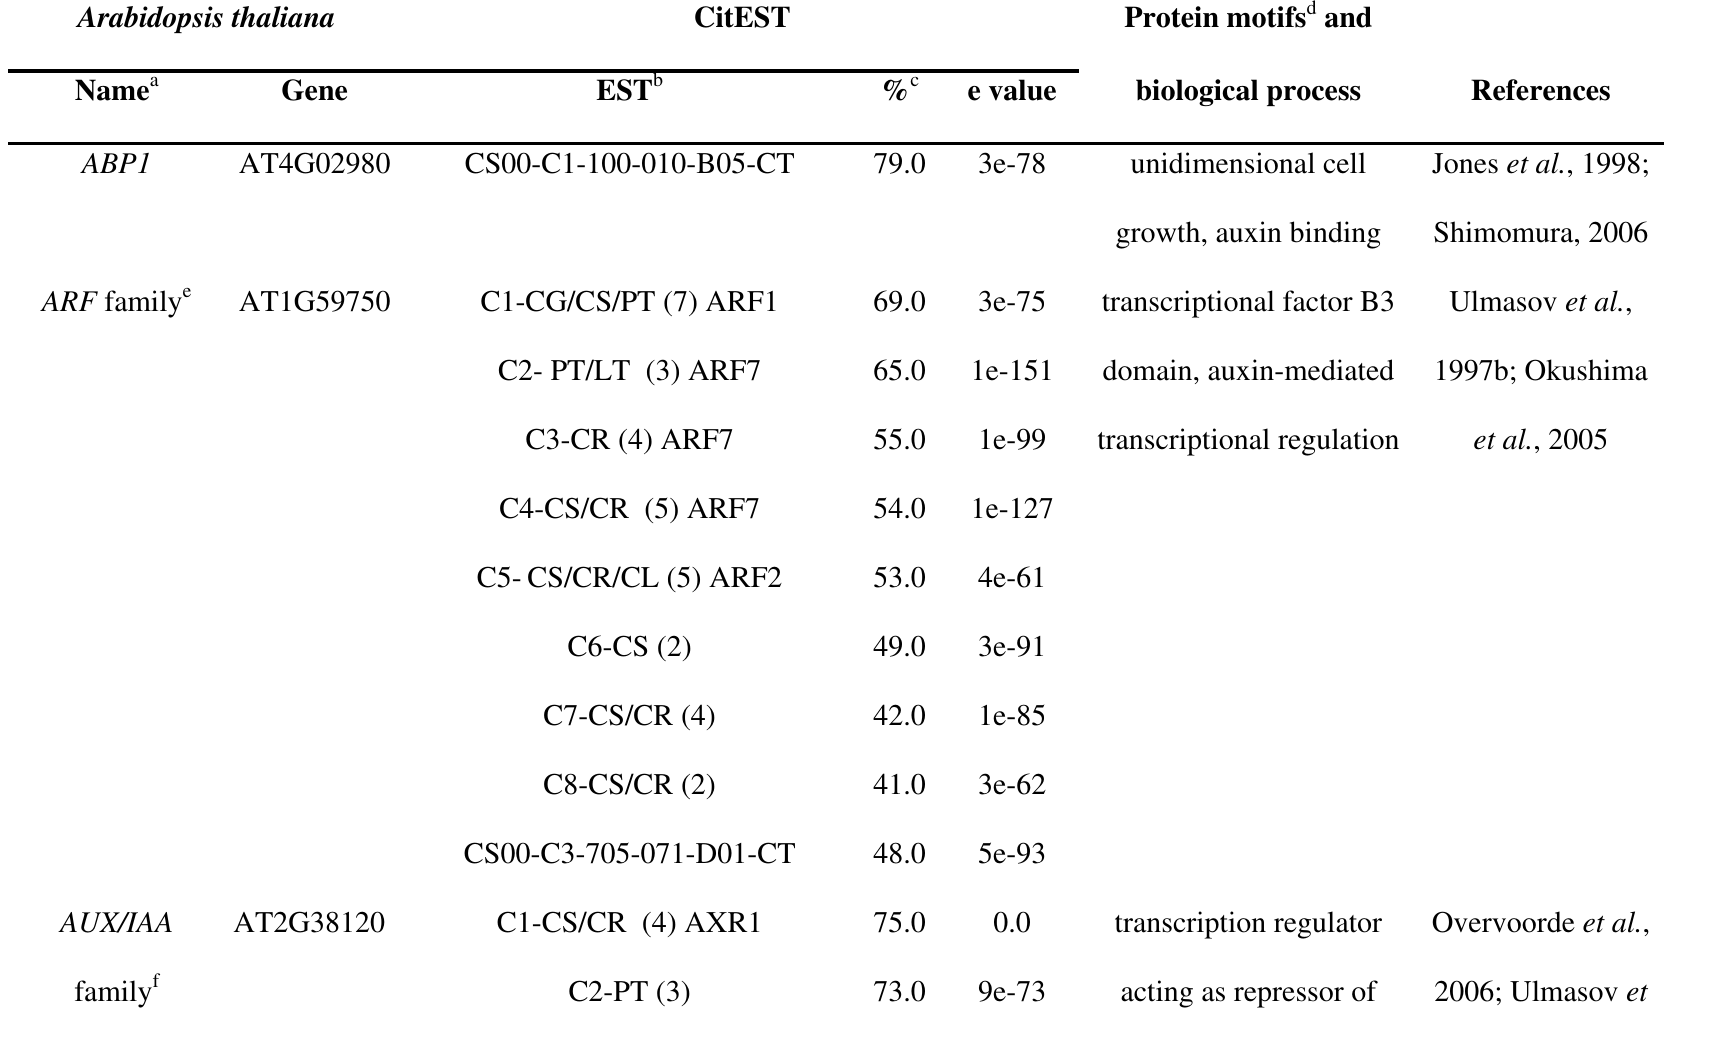
Table S3 – Citrus ESTs homologous to Arabidopsis functionally-characterized auxin signaling pathway genes. Arabidopsis